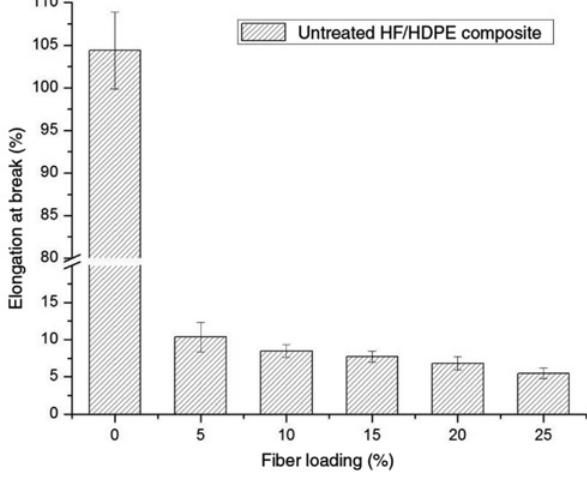
Figure 8: Effect of fiber loading on the elongation at break of untreated HF/HDPE-reinforced